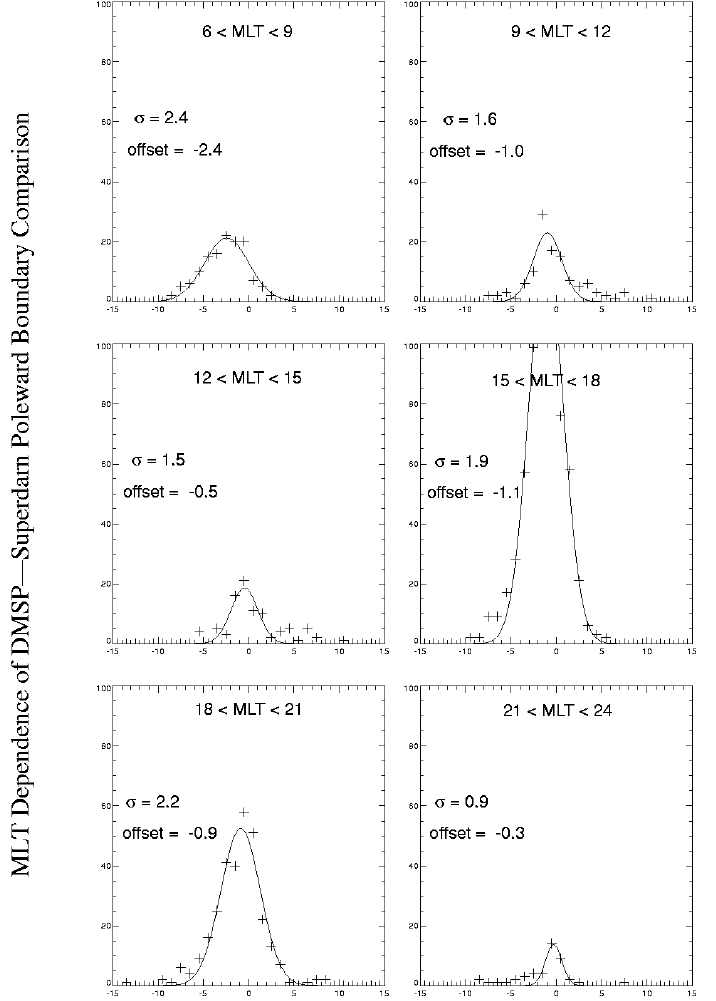
Fig. 1. The cross-calibration between the DMSP determination of the open- closed boundary and the SuperDARN determination of the CRB. The CRB al- ways lies poleward of the open/closed